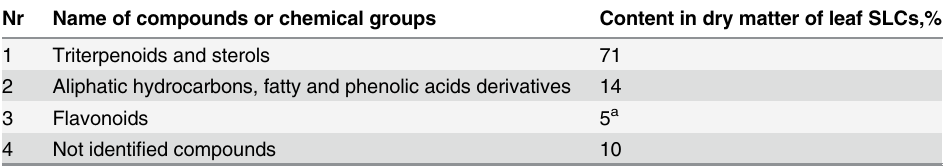
Table 2. General content of lipophilic compounds washed by 96% ethanol from surface of Betula pen- dula leaves. Nr Name of compounds or chemical groups